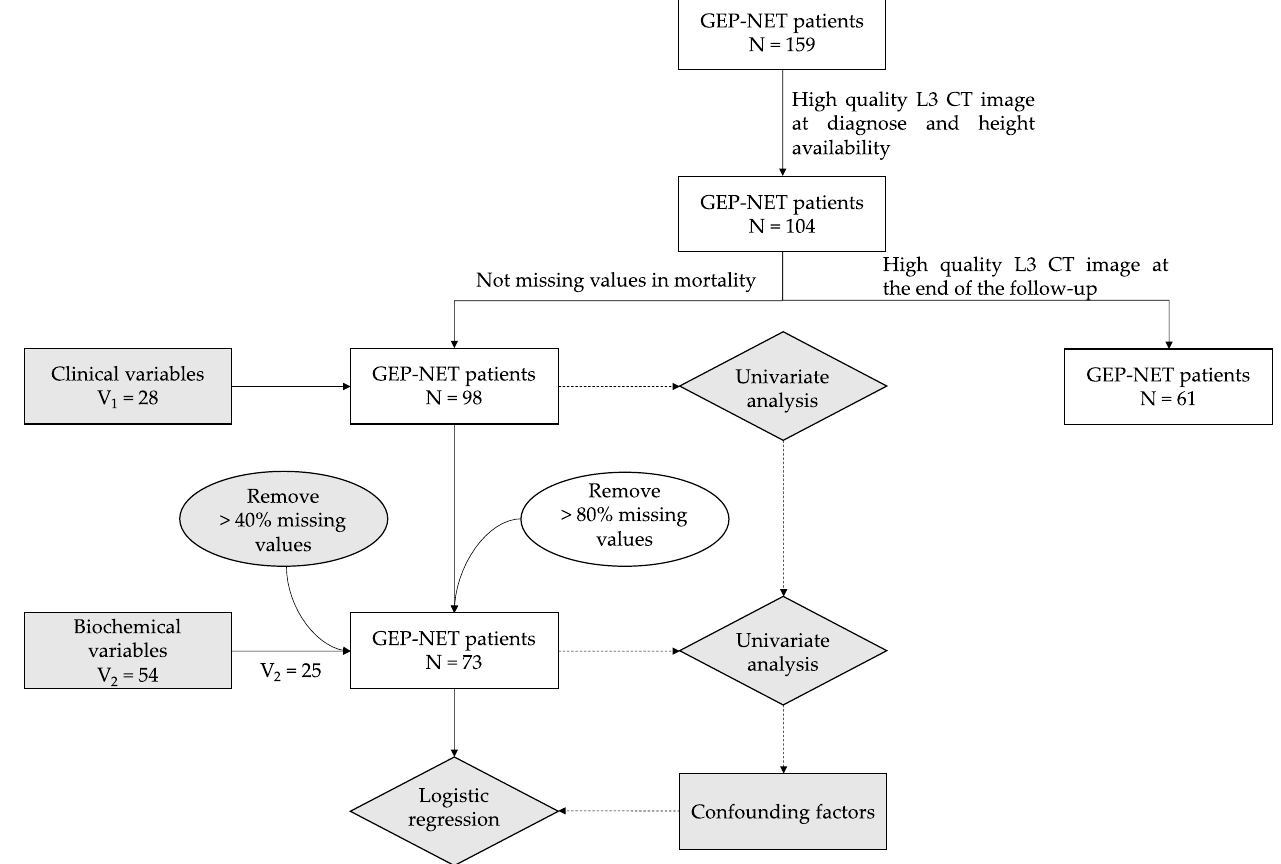
Figure 1. Recruitment strategy flow chart. Patients and variables selection from hospital database. GEP-NET, gastroenteropancreatic tumors; CT, computed